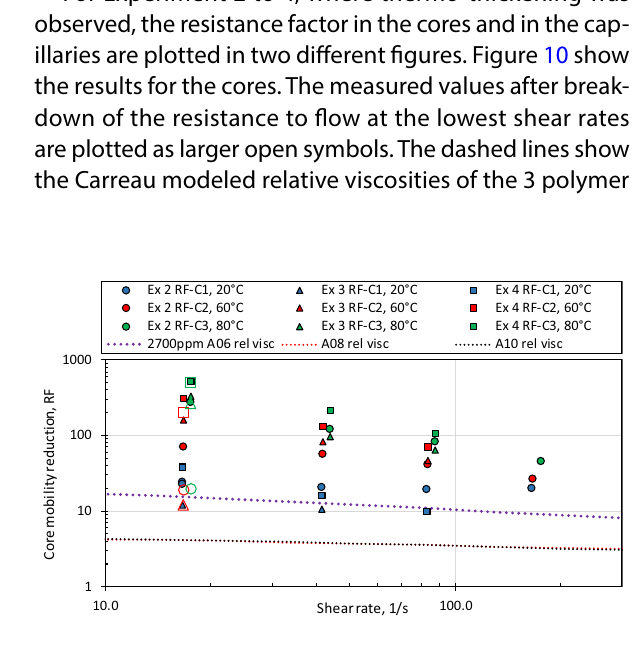
Fig. 10 RF pm as a function of shear rate in the Bentheimer cores in Experiment 2 – 2700 ppm A06, Experiment 3 – 1000 ppm A08 and Experiment 4 – 1000 ppm A10, all in SSW. Both the maximum RF RF pm (filled symbols), and pm after breakdown (open symbols) are plotted. The squares are used for Experiments 4, triangles for Experiment 3 and circles for Experiment 2. Blue markers are used for 20 °C, red for 60 °C and green for 80 °C. The dashed lines are the relative viscosities from the Carreau model (Eq. 4) fitted to meas- urements performed with Anton Paar Rheometer at 20